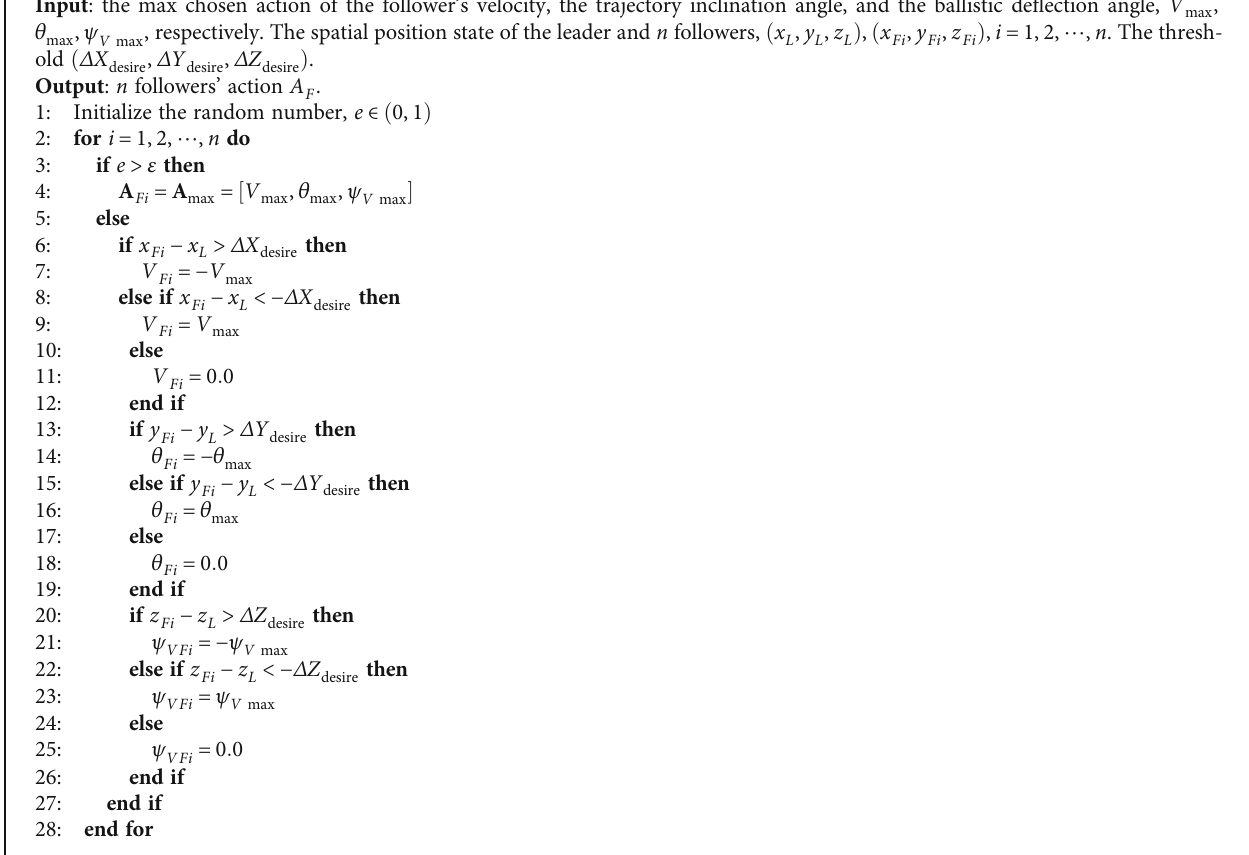
Algorithm 1: ε -imitation action selection